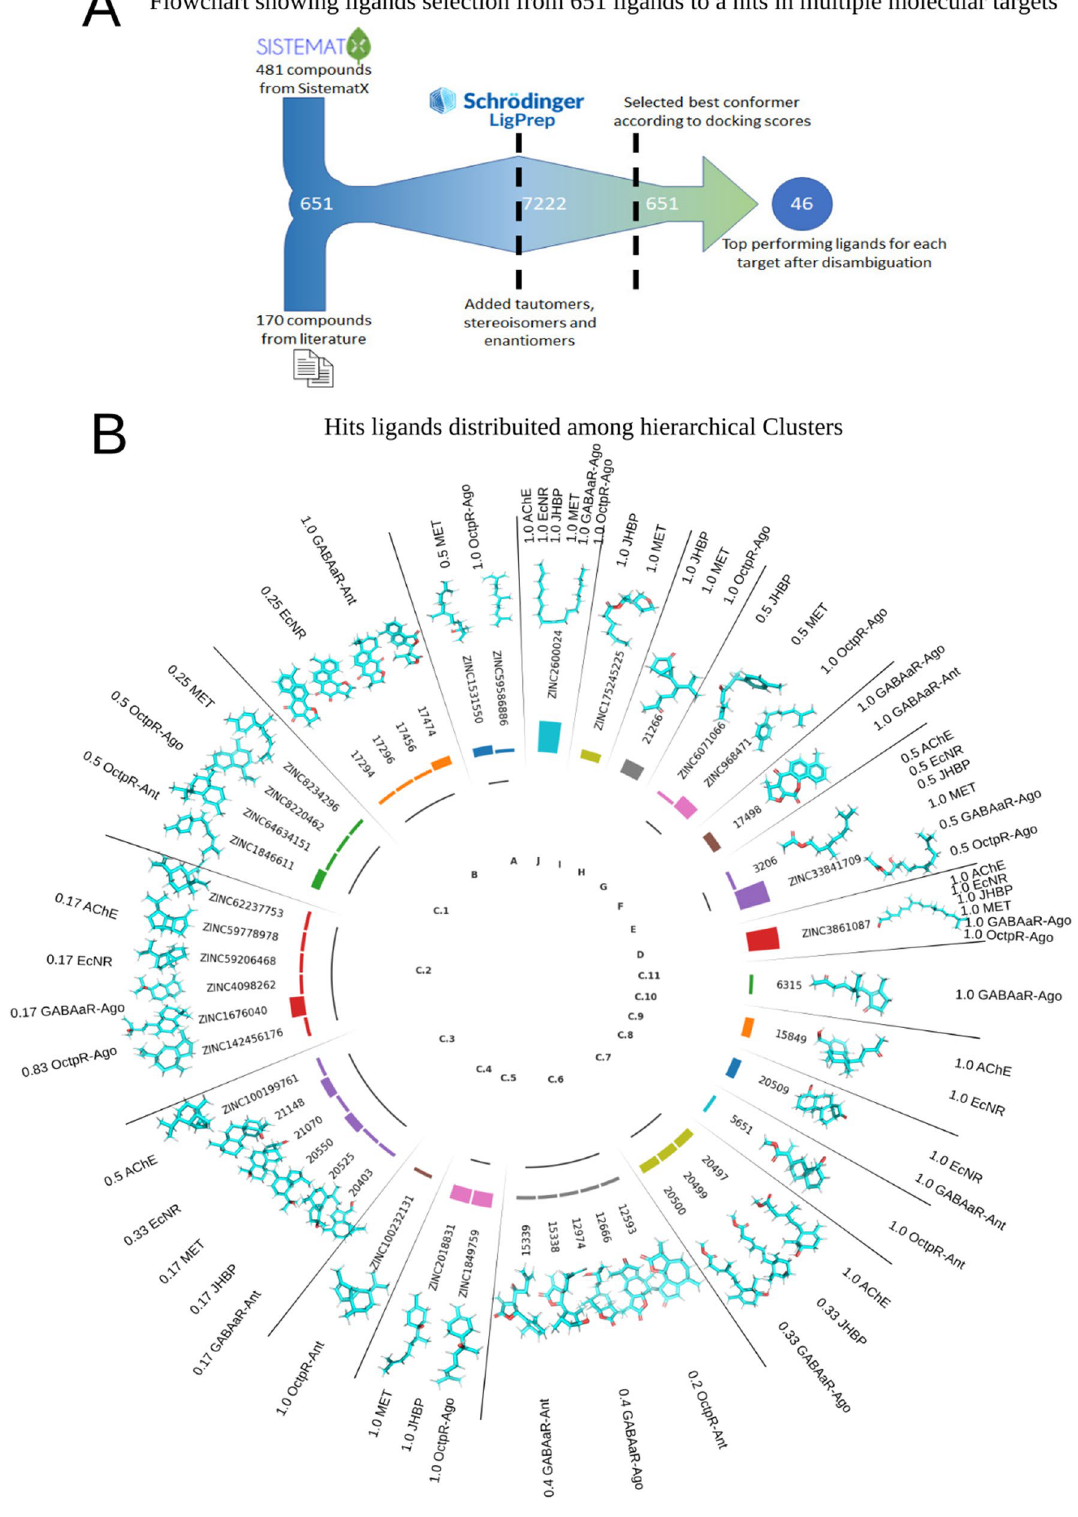
Figure 2. ( A ) Flowchart showing the virtual screening of dataset ligands until achieve the 46 Top hits ligands. ( B ) Distribution of hits ligands for blowfly targets among hierarchical clusters, the bar height represents the number of targets high scored by the ligand. The chemical structure is shown, and numbers represent the probability of a blowfly target being affected by the hierarchical